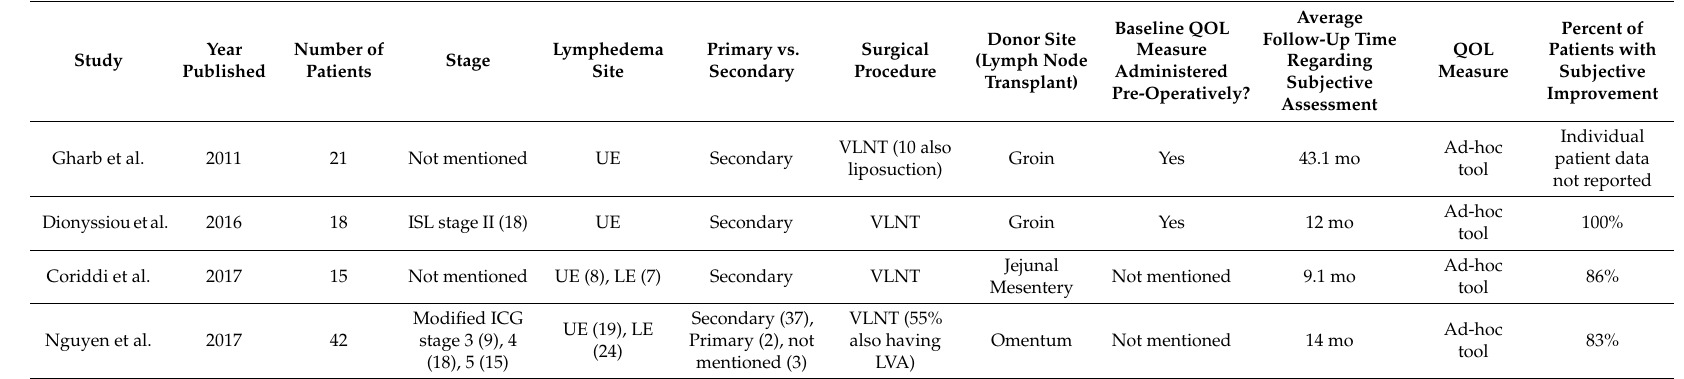
Table 4. QOL in VLNT using ad-hoc